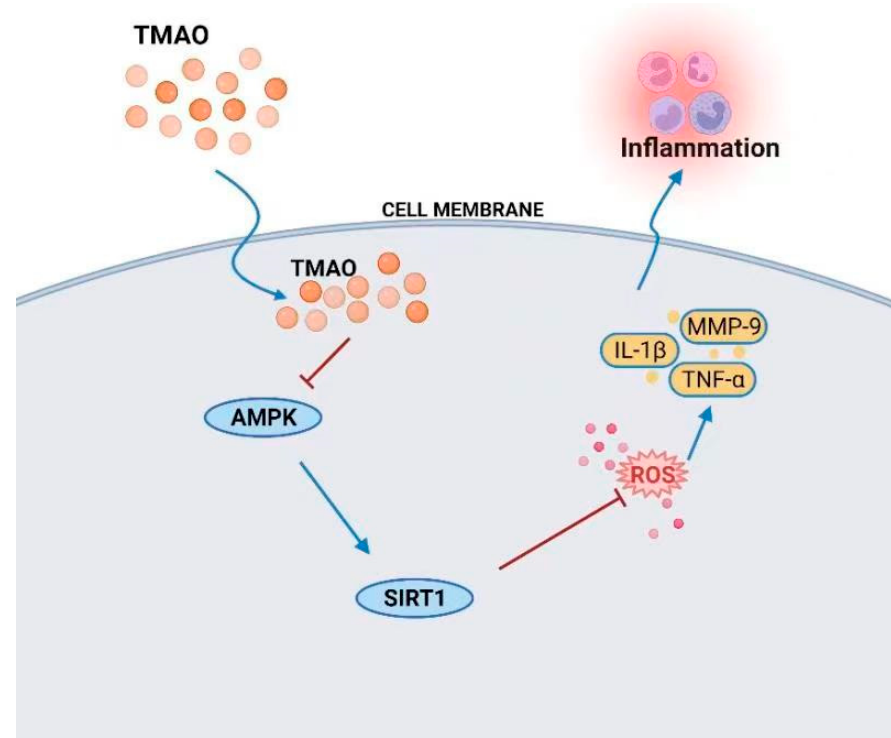
Figure 9. TMAO ‐ mediated inflammation via ROS and the AMPK/SIRT1 ‐ signaling pathway. Figure 9. TMAO-mediated inflammation via ROS and the AMPK/SIRT1-signaling Supplementary Materials: The following supporting information can be downloaded at: www.mdpi.com/xxx/s1, Figure S1: The protein levels of inflammatory cytokines in VSMCs and HU ‐